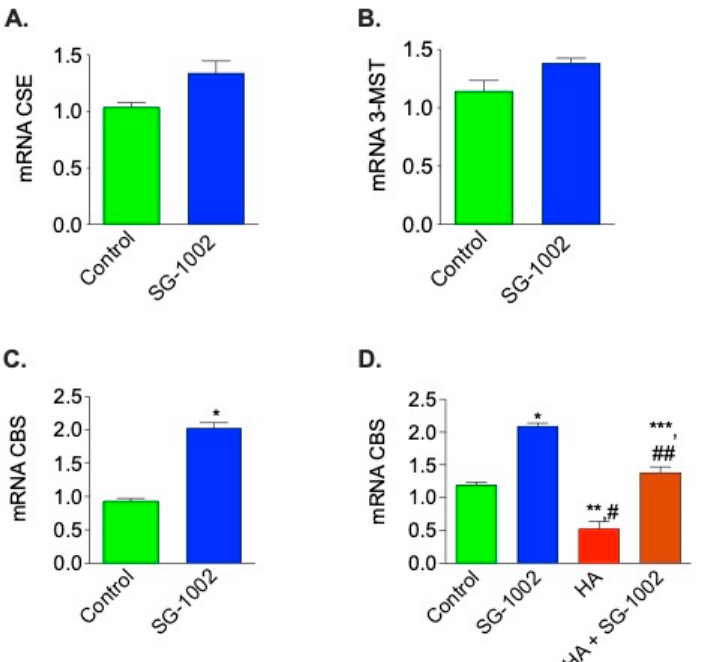
Figure 2. Effects of SG-1002 on mRNA Expression of CBS, CSE, and 3-MST in HL-1 cells. HL-1 cells were incubated with specific reagents as described in Materials and Methods for 1 h in 1% serum containing media. cDNA was prepared from RNA obtained from treated HL-1 cells followed by analysis of mRNA of CSE ( A ), 3-MST ( B ), and CBS ( C , D ) using TaqMan PCR assay system. *, p < 0.05 vs. control, ( A – C ), ( t test) (n = 4); *, and **, p < 0.05 vs. control; #, p < 0.05 SG-1002 vs. HA; ##, p < 0.05 HA vs. SG-1002 +HA; ***, p < 0.05 SG-1002 vs. SG 1002 + HA (D) (Anova) (n = 3).